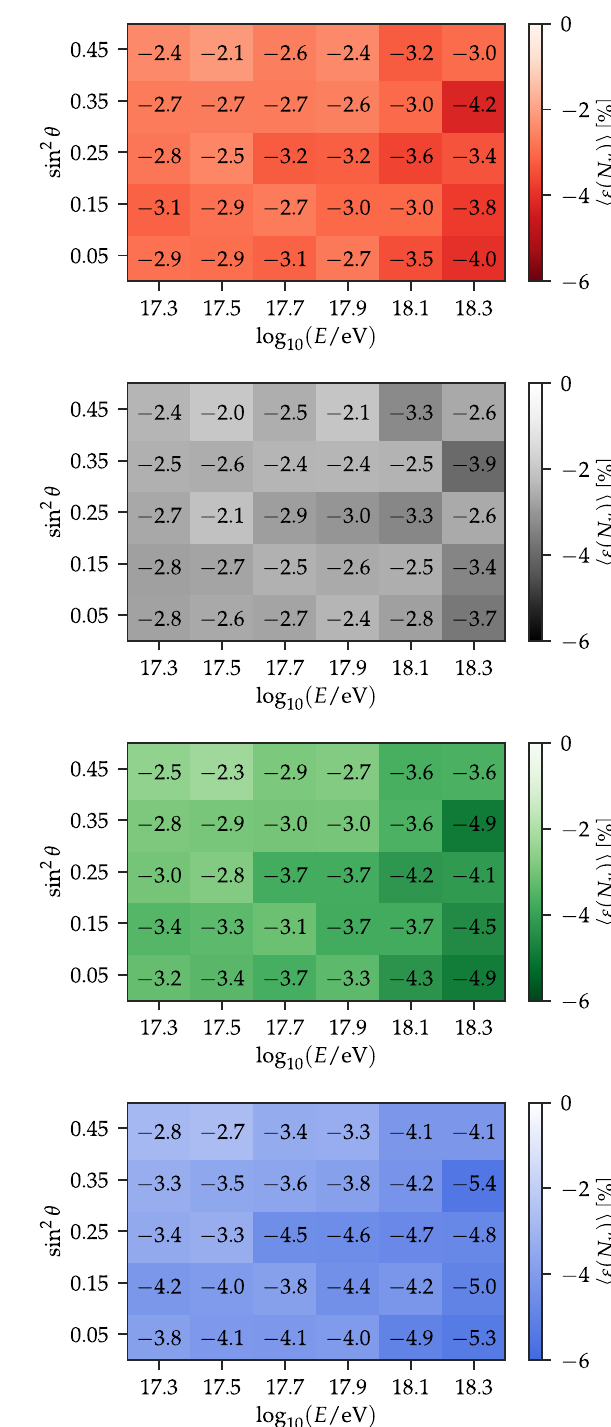
Fig. 17 Same as Fig. 12, but considering iron